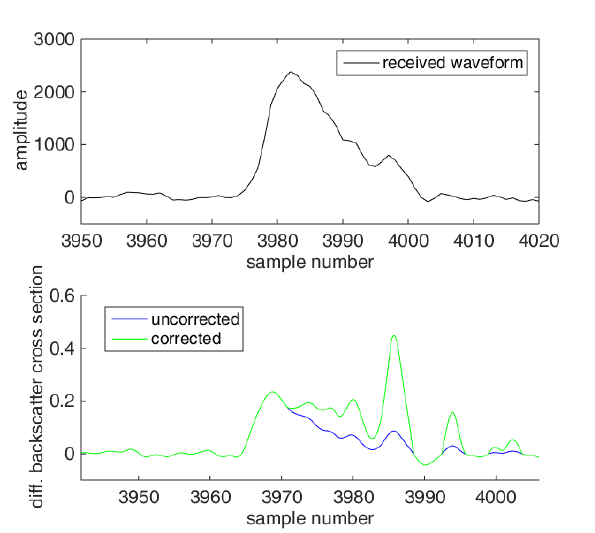
Figure 12. Recorded waveform (top), differential backscatter cross section (bottom blue) and attenuation-corrected differential backscatter cross section (bottom green) (Richter et al.,